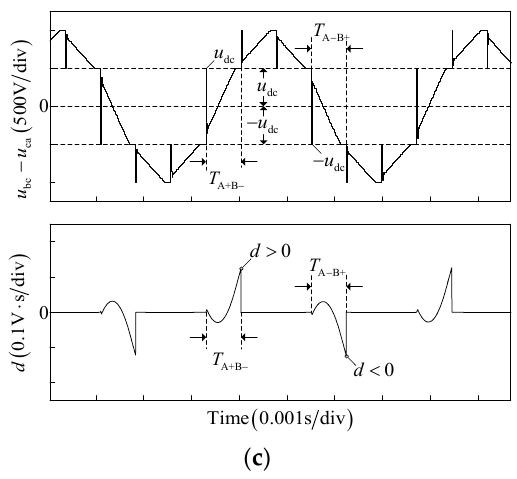
( c ) u u  and integral d in the conduction period of phase A+B - Figure 4. Line voltage difference   Figure 4. Line voltage difference ( u bc − u ca ) and integral d in the conduction period of phase A+B bc ca and A - B+. ( a ) Accurate commutation; ( b ) Advanced commutation; ( c ) Delayed commutation.